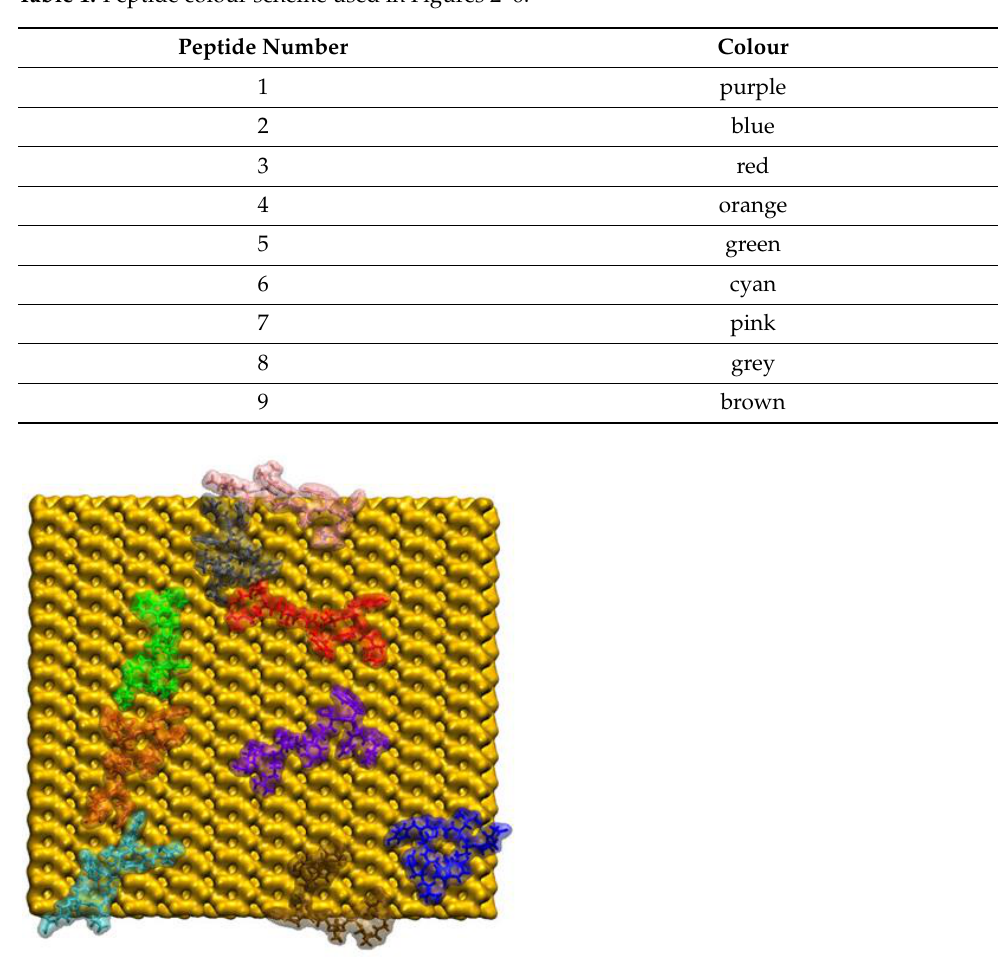
Figure 2. The final configuration of the 9 GnRH-I peptides adsorbed to the model silica surface as viewed from above. The GnRH-I proteins are shown as transparent surfaces overlapped on opaque licorice VMD representations with each peptide given a different colour for ease of identi- fication (see Table 1), while the silica as a yellow surface. The water molecules and ions are not shown for